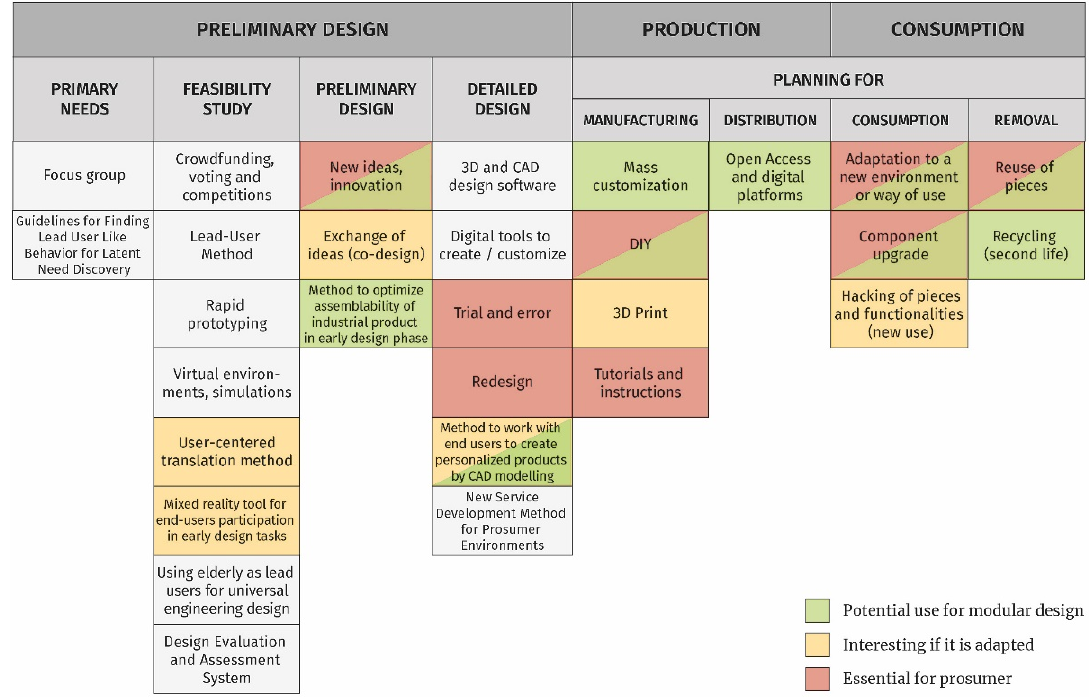
Figure 3. Analysis of current methods and tools for the prosumer.